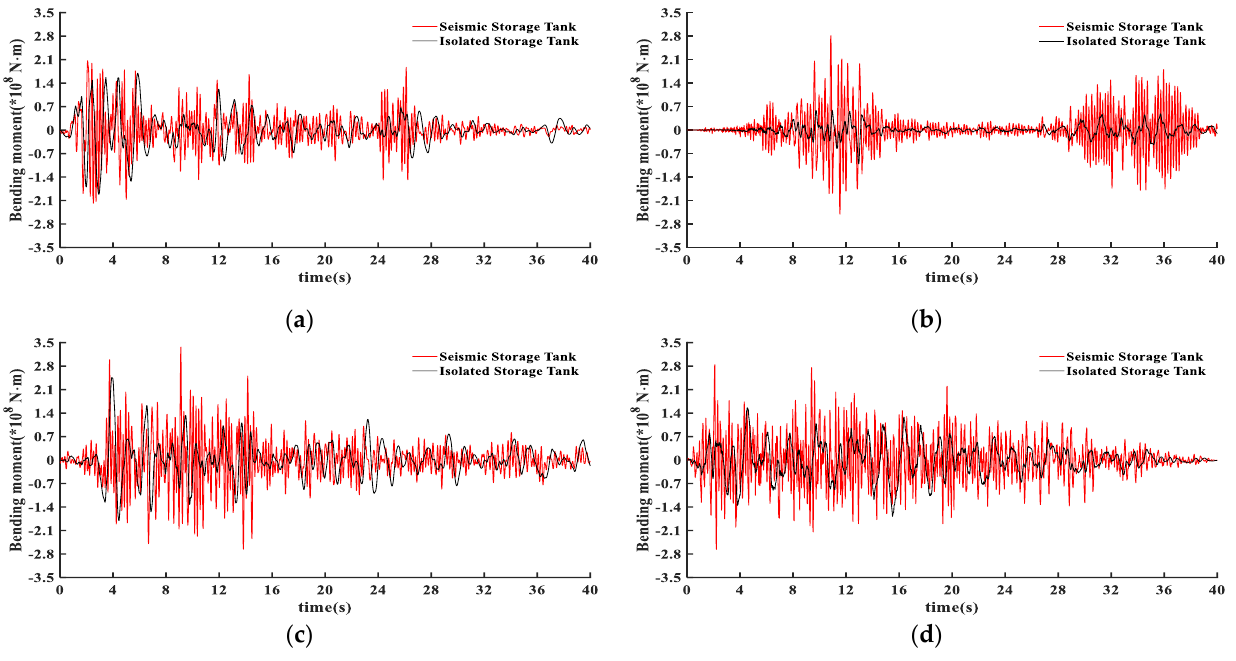
Figure 14. Overturning bending moment: ( a ) El Centro wave; ( b ) Wolong wave; ( c ) Taft wave; ( d ) Artificial wave.